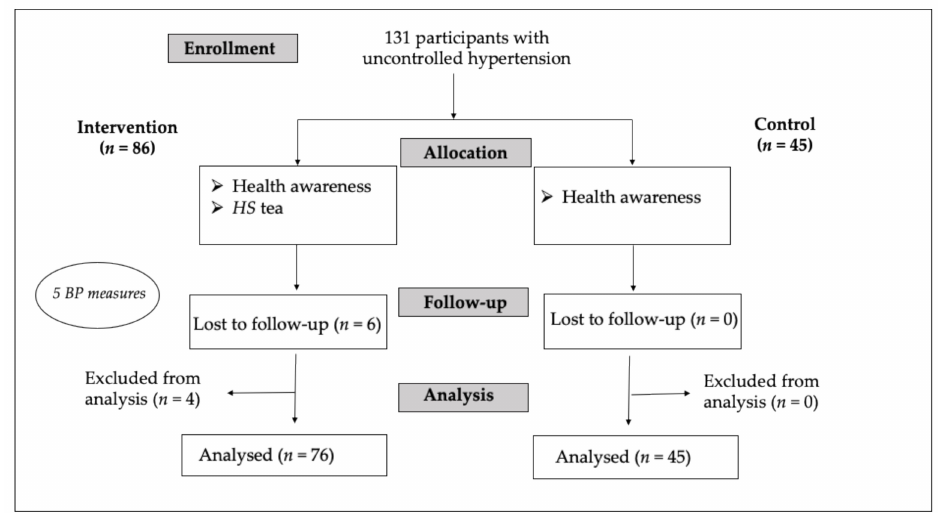
Figure 1. Participant’s